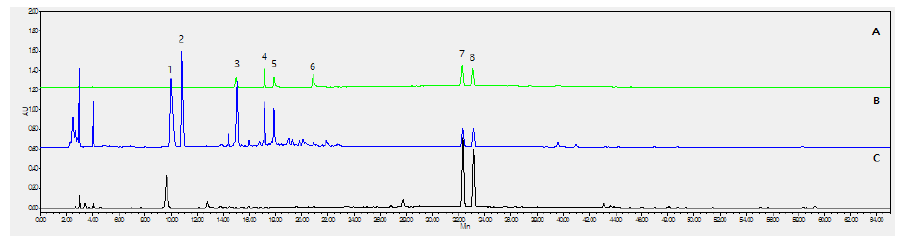
Figure 1. HPLC profile of HBX-5. ( A ) Mixed standards; ( B ) before acid hydrolysis; ( C ) after acid hydrolysis. ( 1 ) psoralenoside; ( 2 ) isopsoralenoside; ( 3 ) morroniside ( 4 ) loganin ( 5 ) echinacoside ( 6 ) verbascoside ( 7 ) psoralen; ( 8 ) isopsoralen.